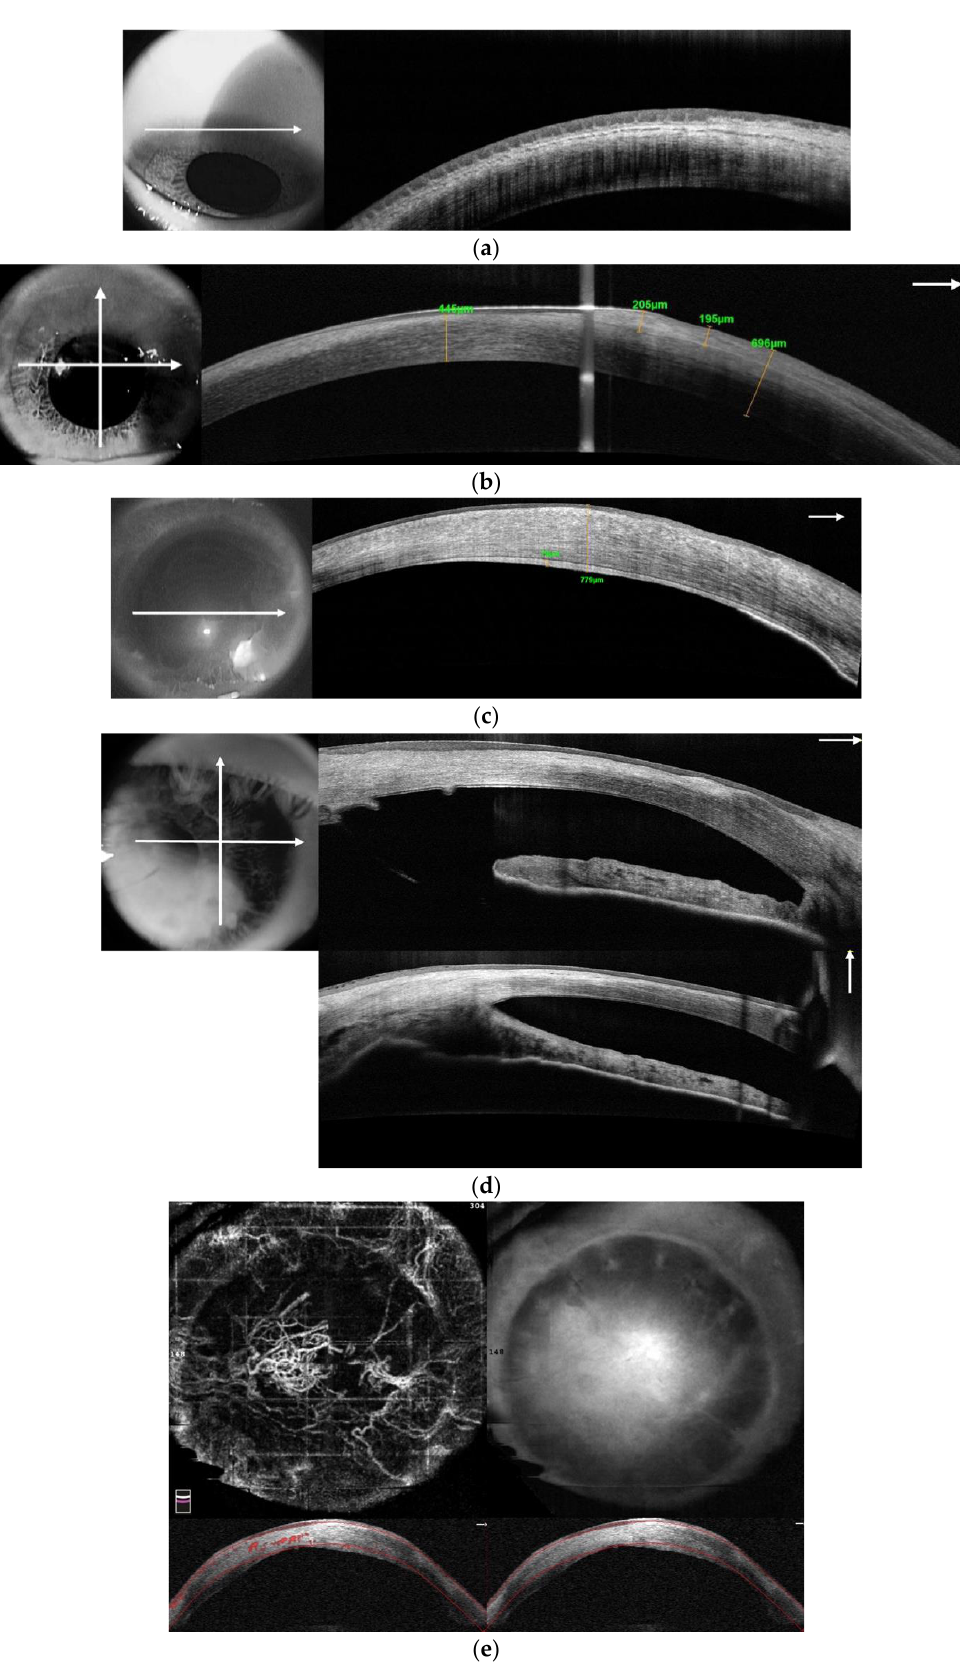
Figure 4. AS-OCT of the cornea. ( a ) Composite image of the upper corneal limbus of the healthy eye of the patient with unilateral LSCD. The sagittal cross-sectional OCT images demonstrate the